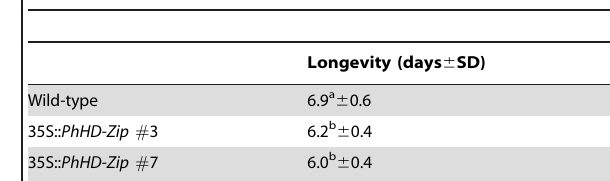
Table 3. Longevity of attached flowers from WT plants and from plants over-expressing PhHD-Zip (35S:: PhHD-Zip lines: # 3 and #